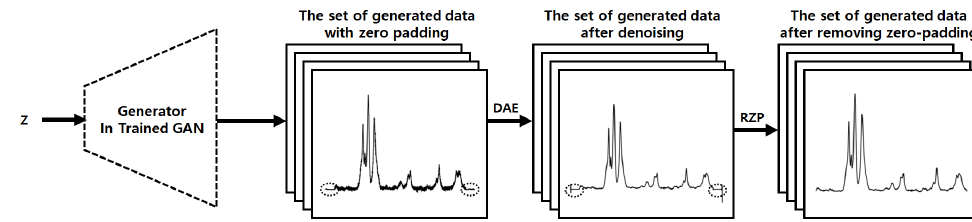
Figure 4. The generation process in the proposed